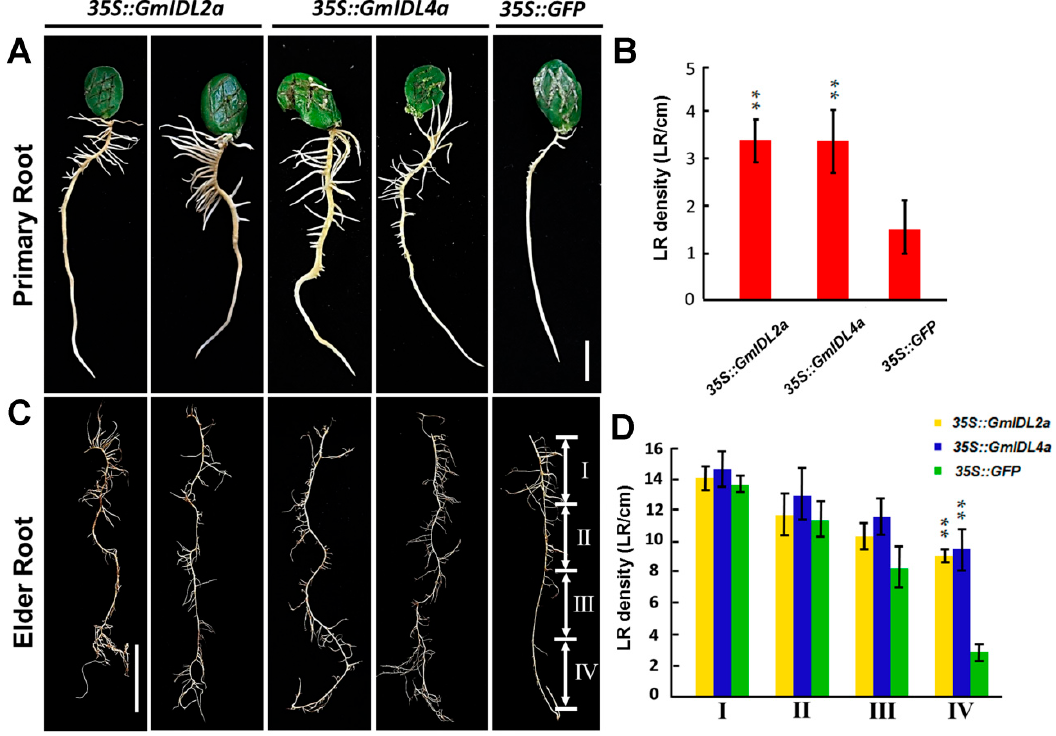
Figure 3. Morphological and statistical analysis of 35S::GmIDL2a , 35S::GmIDL4a , and 35S::GFP primary and elder roots. ( A ) Morphologies of 35S::GmIDL2a , 35S::GmIDL4a , and 35S::GFP primary